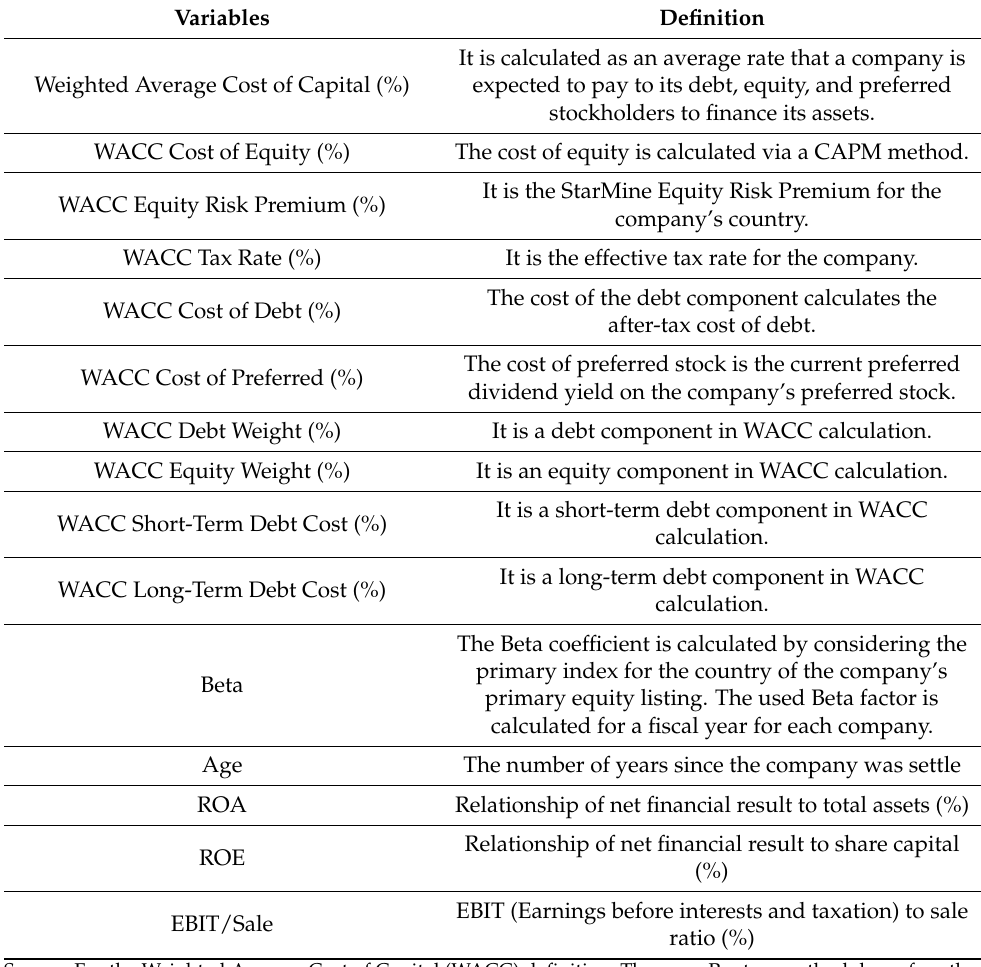
Table 1. Definition of variables.